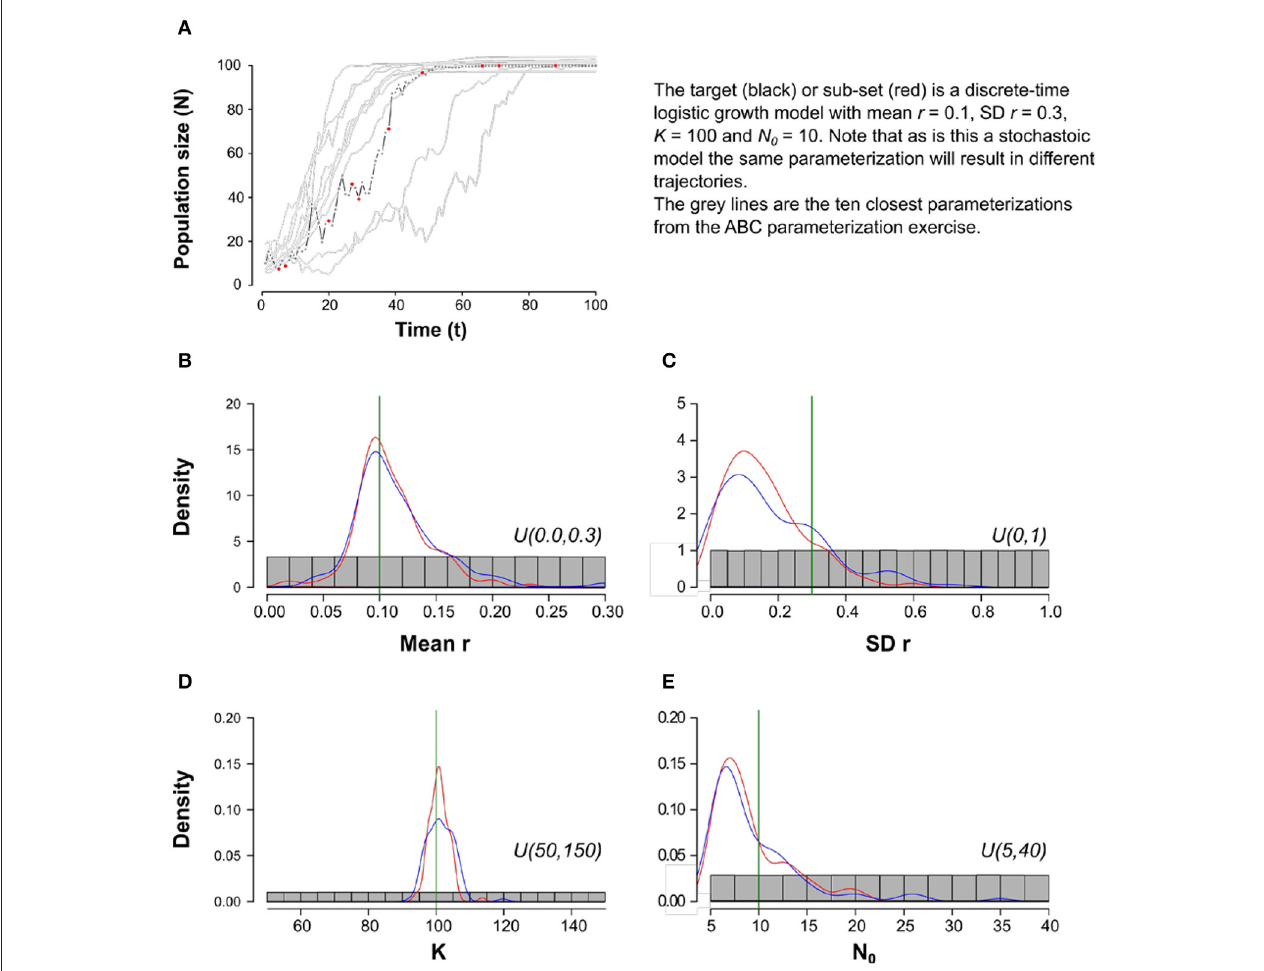
FIGURE 4 | A simple example of the ABC reject-accept approach. In this example, the “target” pattern is a population trajectory (A) arising from a discrete-time logistic population model with stochasticity in the growth term r . There are four parameters we wish to estimate ( µ [ r ], σ [r], K , n 0 ); to do so we simulate the population model 1 × 10 6 times, each time drawing values for the four unknown parameters from a broad uniform distribution (the “prior”; gray). For each simulation, we assess how close the trajectory is to the target using the summed squared difference across the entire series (red) and the Euclidean distance (blue) between 10 irregularly spaced observation points. We retain the 100 simulations closest to the observed pattern and from these estimate posterior distributions for each of the parameters (B–E) . Vertical green lines are the true parameter